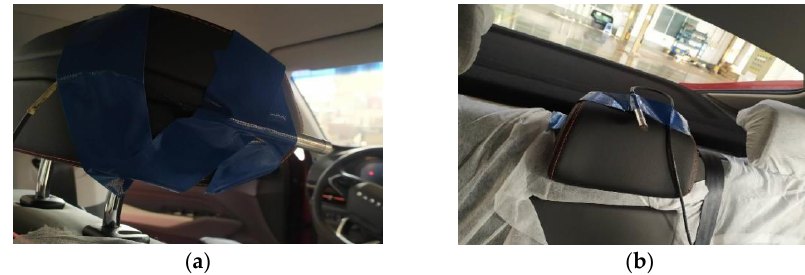
Figure 4. Position of sound pressure sensors. ( a ) driver’s seat , ( b ) passenger’s seat .